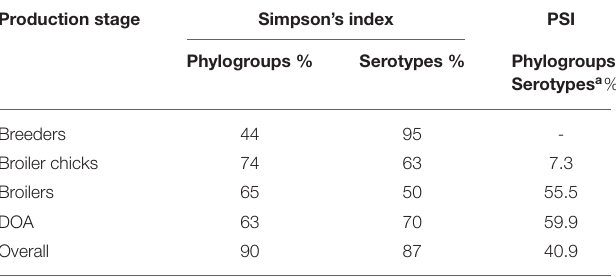
TABLE 1 | Simpson’s Index (SI) and proportional similarity index (PSI) for APEC in different sampling